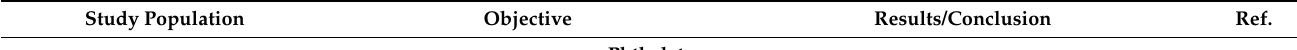
Table 4. Epidemiologic studies of measurement of phthalates and bisphenols in a patient